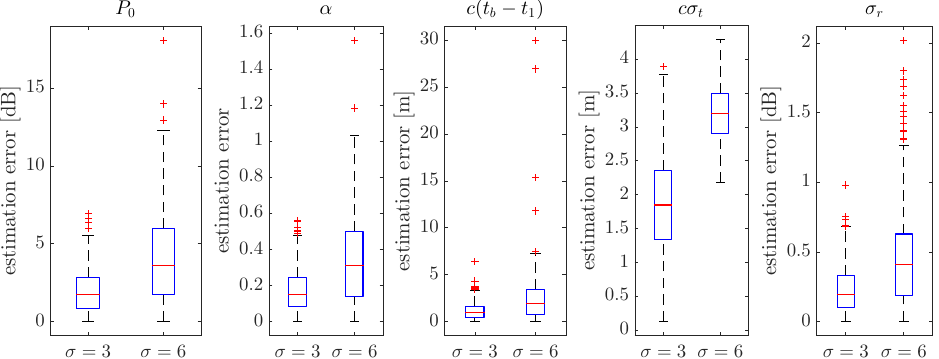
Figure 6. Estimation errors obtained during the calibration phase for σ ∈ { 3,6 } with α = 2 and N =